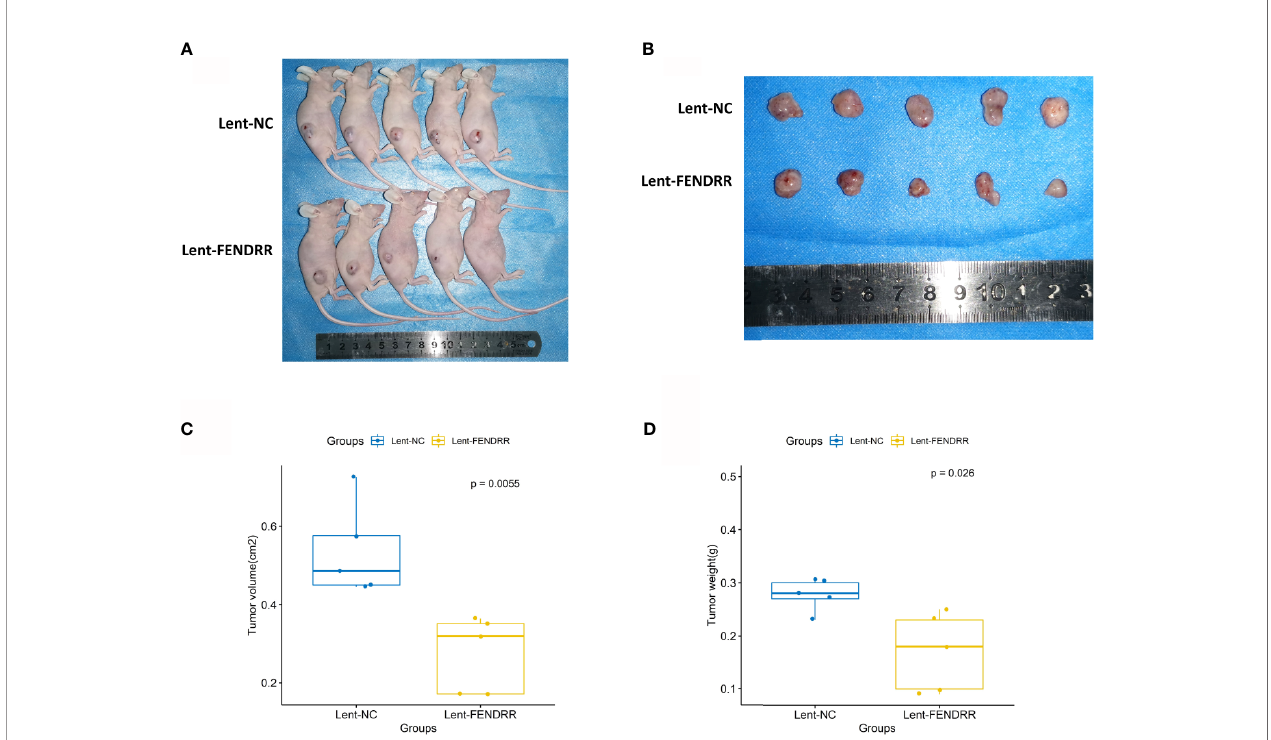
FIGURE 6 | Overexpression of FENDRR in CAFs inhibits the progression of OSCC in vivo . (A) Images of nude mice from the Lent-NC and Lent-FENDRR groups. (B) Xenograft tumors excised from nude mice. (C) Volumes of the xenograft tumors excised from nude mice. (D) Weights of the xenograft tumors excised from nude